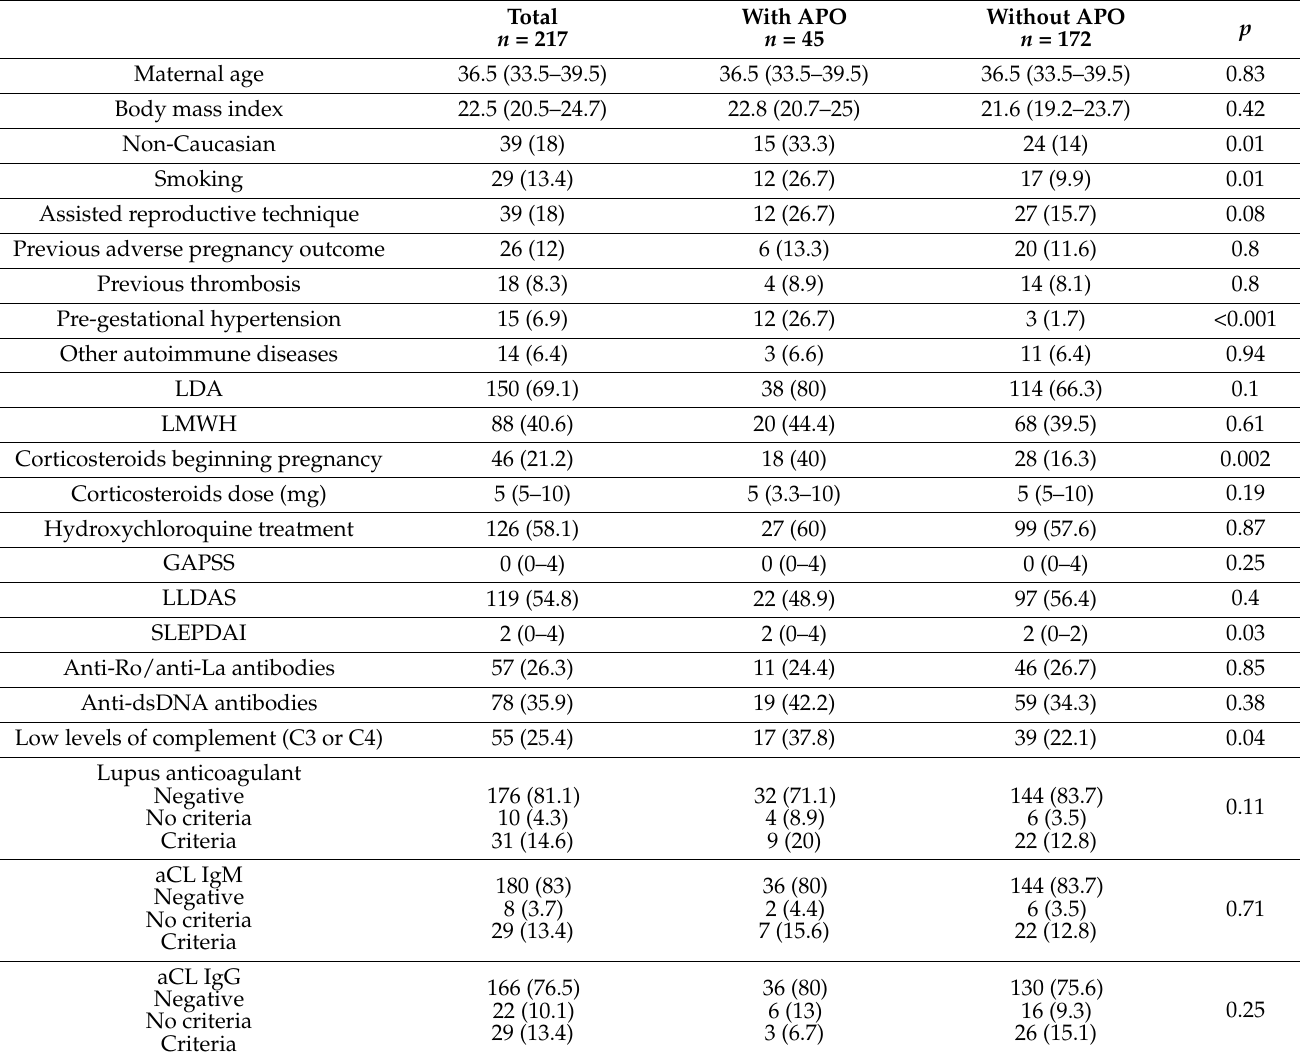
Table 2. Characteristics of study population and their association with adverse pregnancy